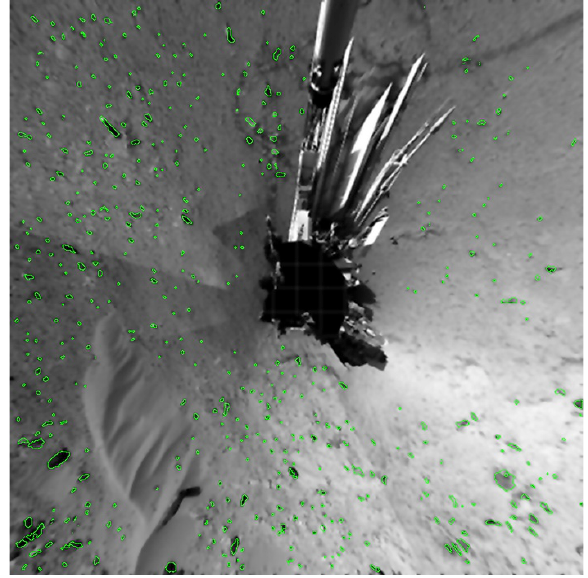
Figure 12 The 0.5cm MSL Navcam vertical projected mosaic (standard JPL RDR product) at Sol 549 (N_L000_0549_ILT027VRT_S_1004_UNCORM2) showing automatically detected rocks (green). Figure 13 Accumulated rock numbers from HiRISE, SRR and Navcam within the same ROI at MSL Sol